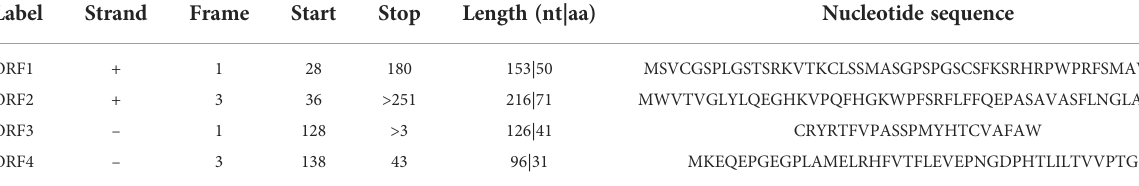
TABLE 3 Open reading frames detected from hsa_circ_0007990.